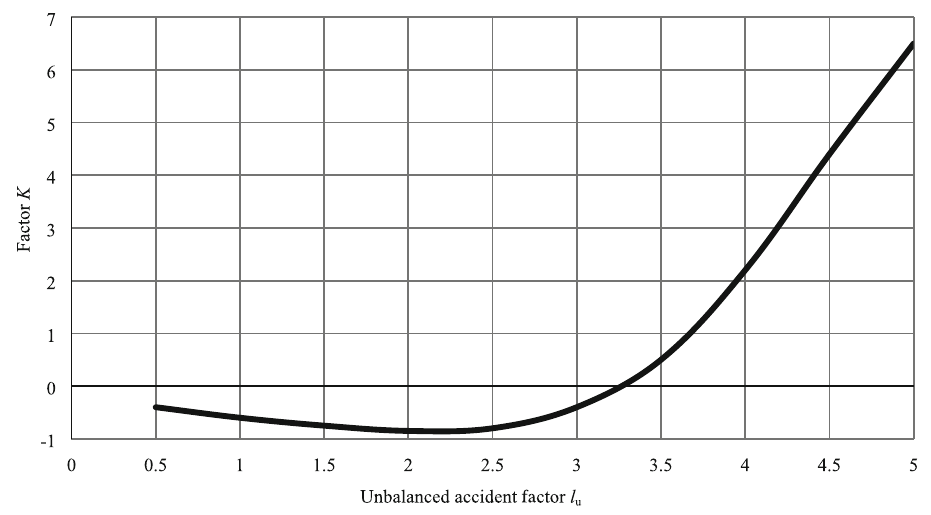
Fig. 7 Relationship between K -factor and unbalanced accident factor l